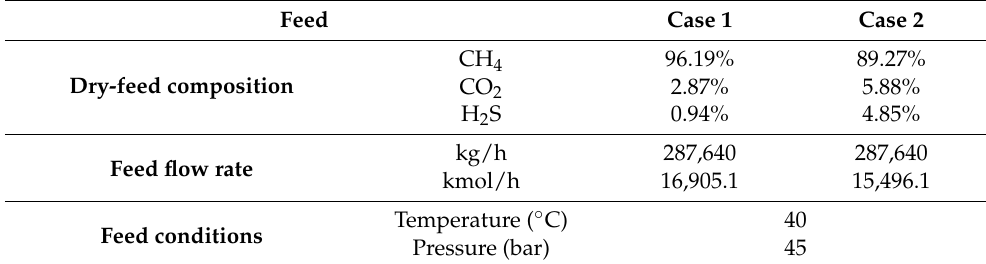
Table 2. Dry-basis compositions of the two tested feeds and their specifications.